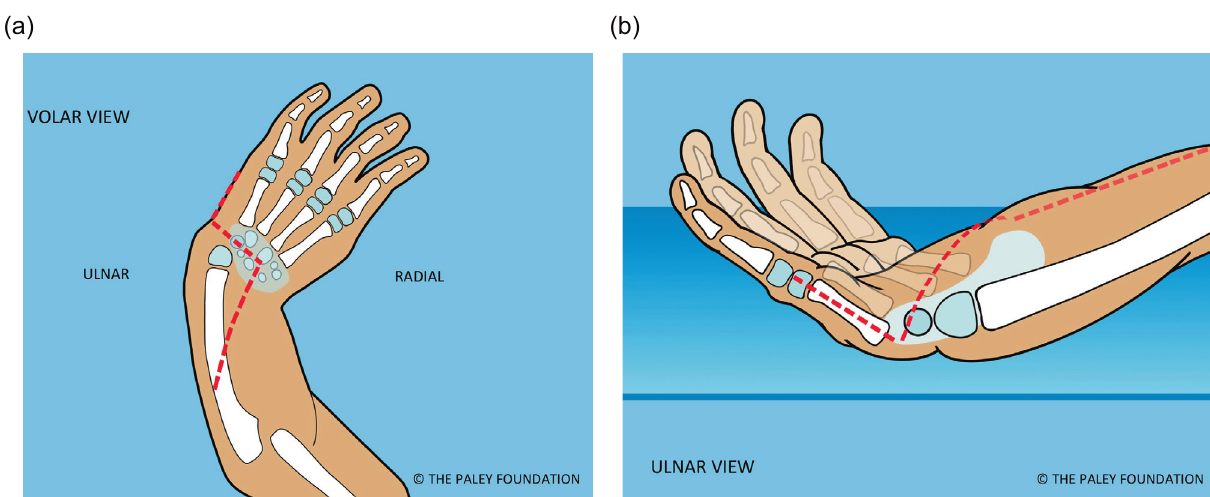
Figure 2. Make a Z-shaped incision. Shown from the volar aspect (a) and from the ulnar side